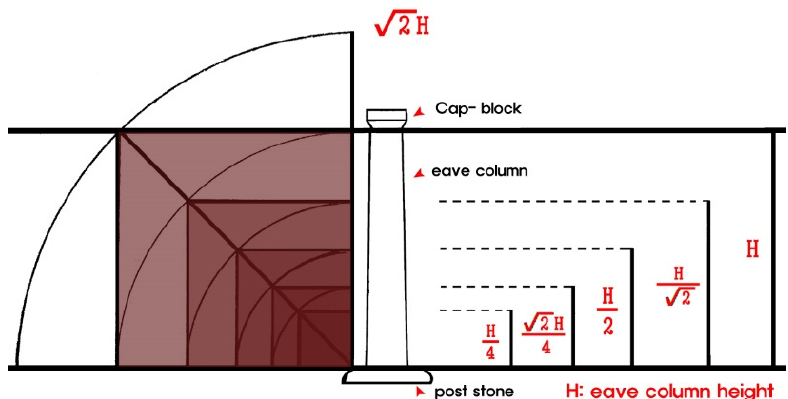
√ 2 H times the eave columns’ height (H). Figure 9. The geometrical diagram based on √2 H times the eave columns’ height (H).